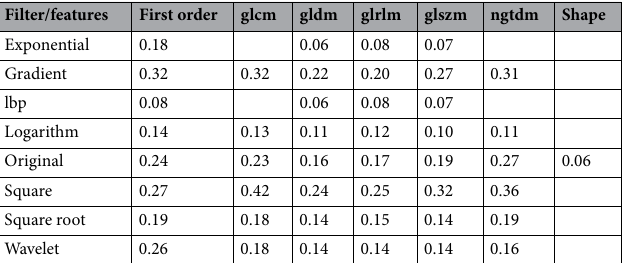
Table 3. Mean absolute correlation coefficients between PyRadiomics and LungTrans features across different types of filters and features.